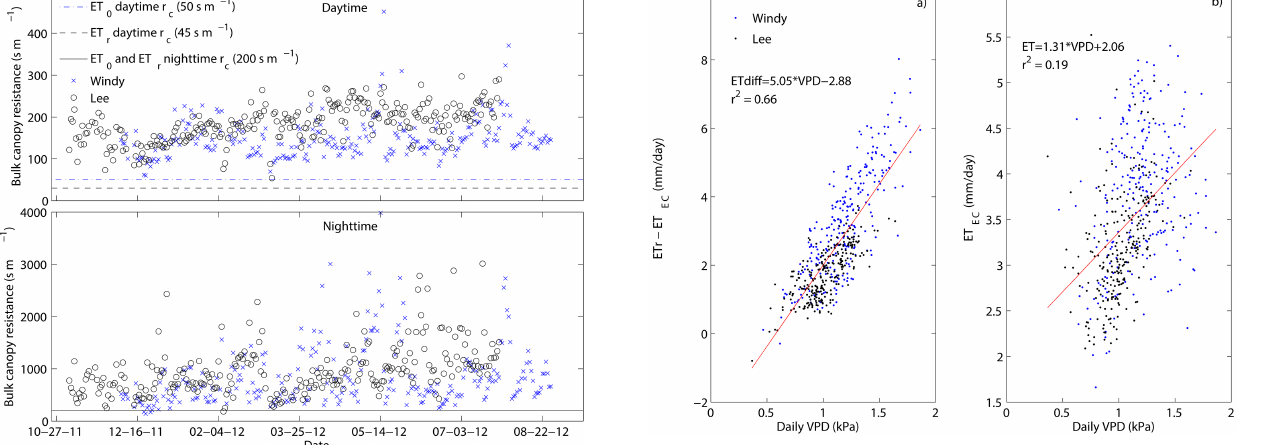
Figure 9. Calculated mean nighttime and daytime bulk canopy re- sistances (following Fig. 6) compared to assumed resistances.